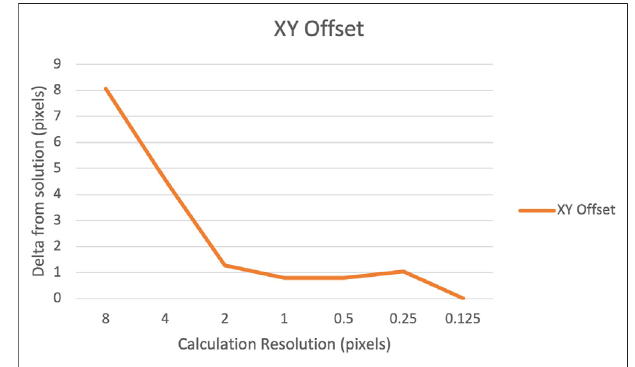
FIGURE8| Chartdemonstratesthesoftwareconvergingonthesolution of the rotational correction as each pass increases in resolution.